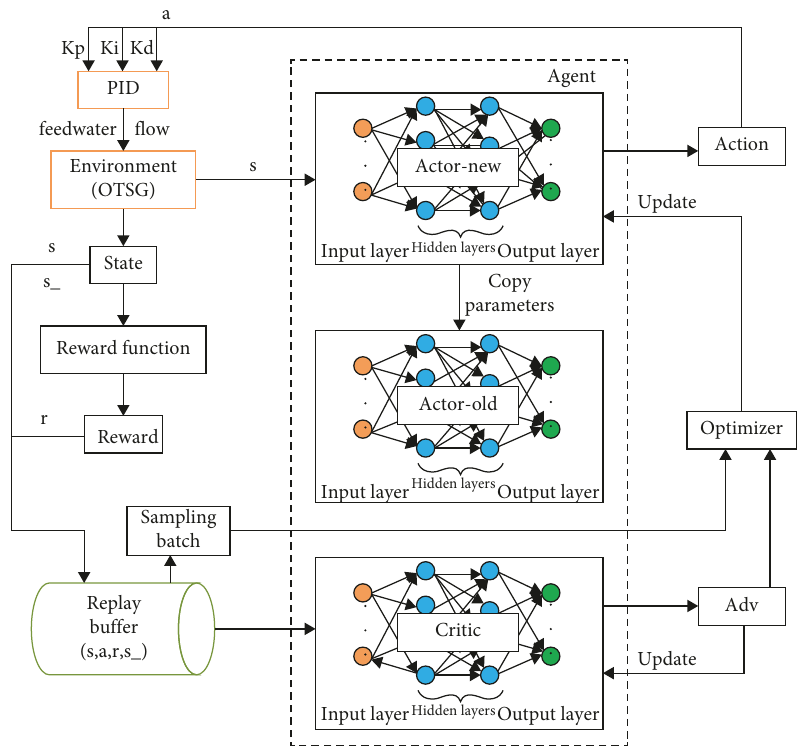
Figure 3: The framework of control structure based on reinforcement